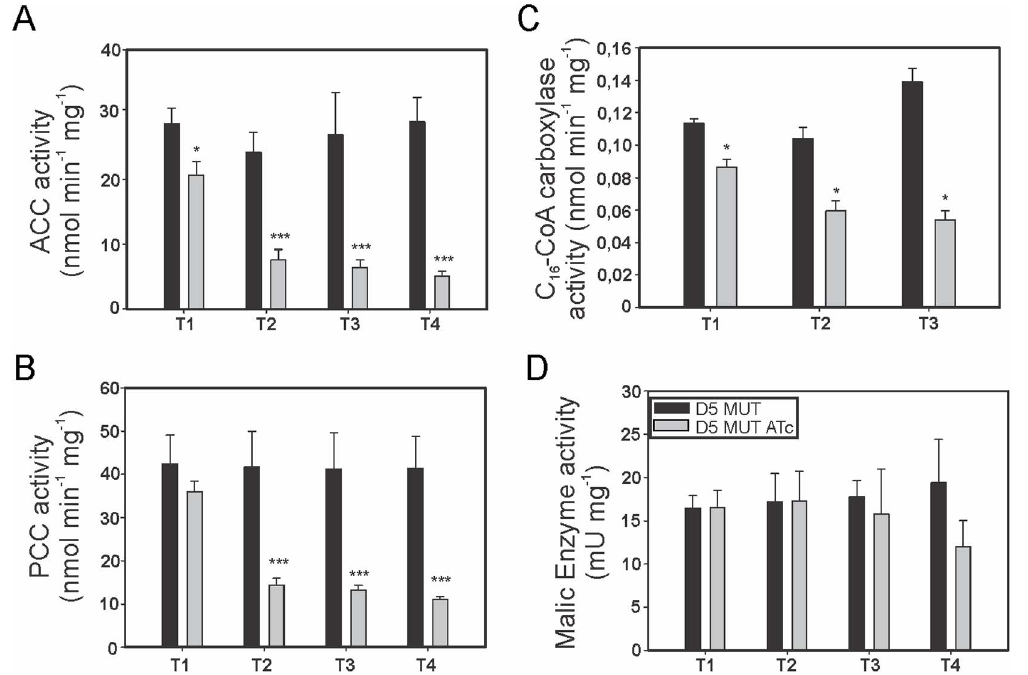
Figure 5. Acyl-CoA carboxylase activity in D5 MUT. Cell-free extracts were prepared from D5 MUT incubated in absence and presence of ATc 200 ng ml 2 1 at the times indicated in Fig. 4A. Determination of A) Acetyl-CoA carboxylase (ACC), B) Propionyl-CoA carboxylase (PCC), C) Long-chain acyl-CoA carboxylase and D) Malic enzyme activities. Levels of activity are the means of the results of three independent experiments 6 standard deviations (n=3). ***, P =0.0001; *, P=0.04.